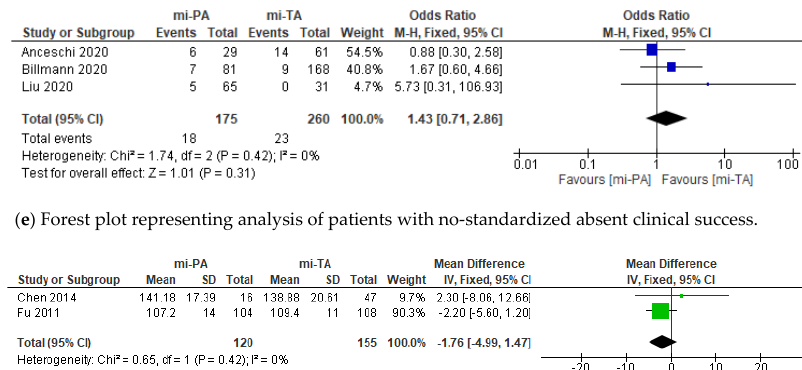
( d ) Forest plot representing analysis of patients with no ‐ standardized complete clinical success.